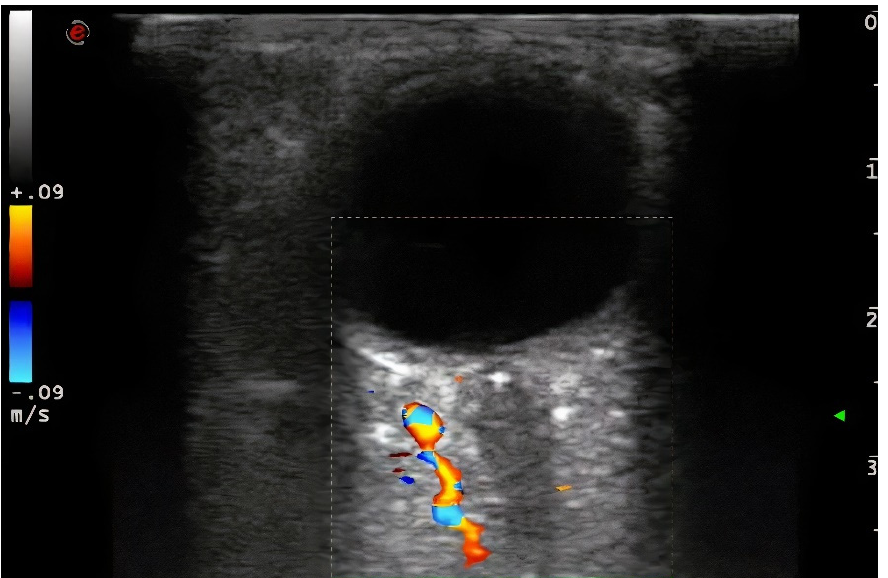
Figure 2. Hyperechoic material in the retrobulbar circulation of the optic nerve (spot sign). Note the abscense of color code flow signal in the peripapillar segment of the CRA. 3–9 MHz linear probe (Esaote MyLab70 and My Lab9, Esaote, Milan).